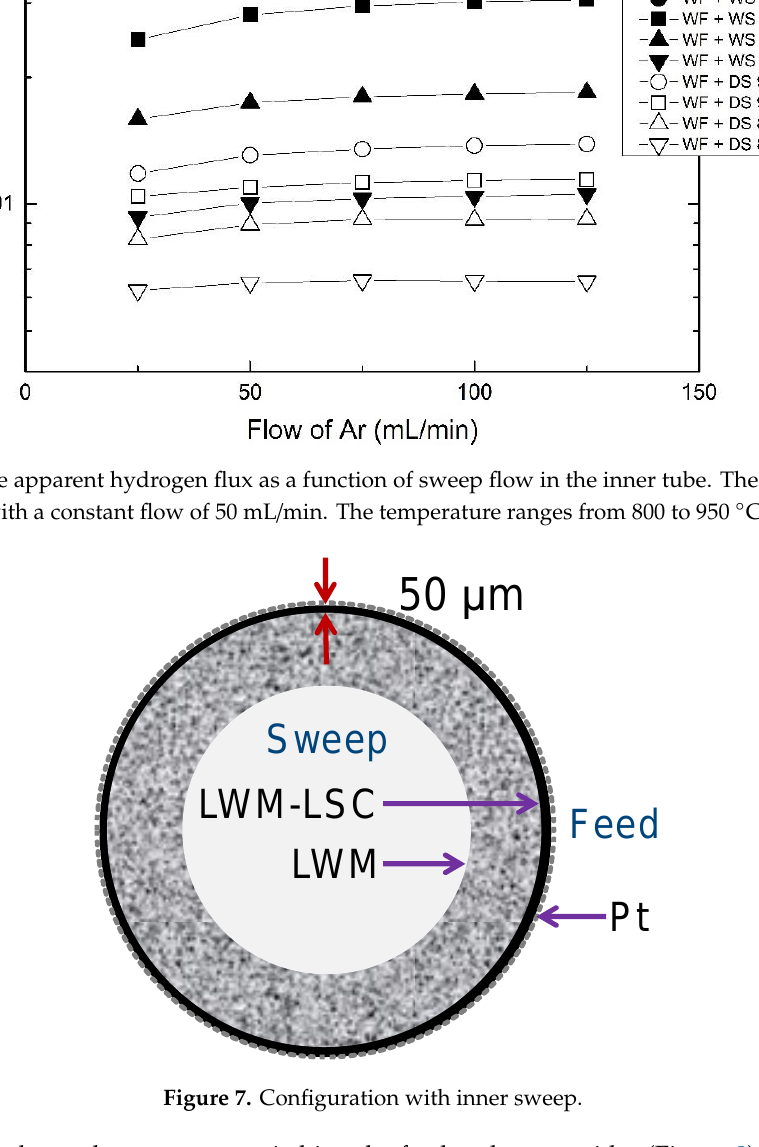
Figure 7. Configuration with inner sweep.